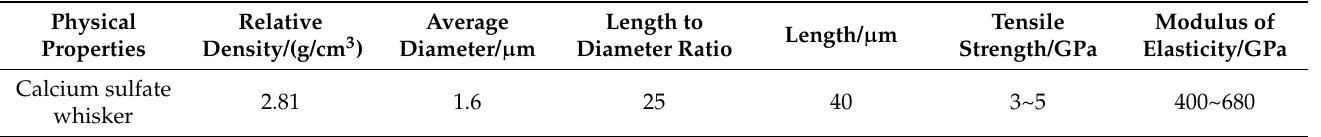
Table 2. Technical specifications of calcium sulfate whisker.